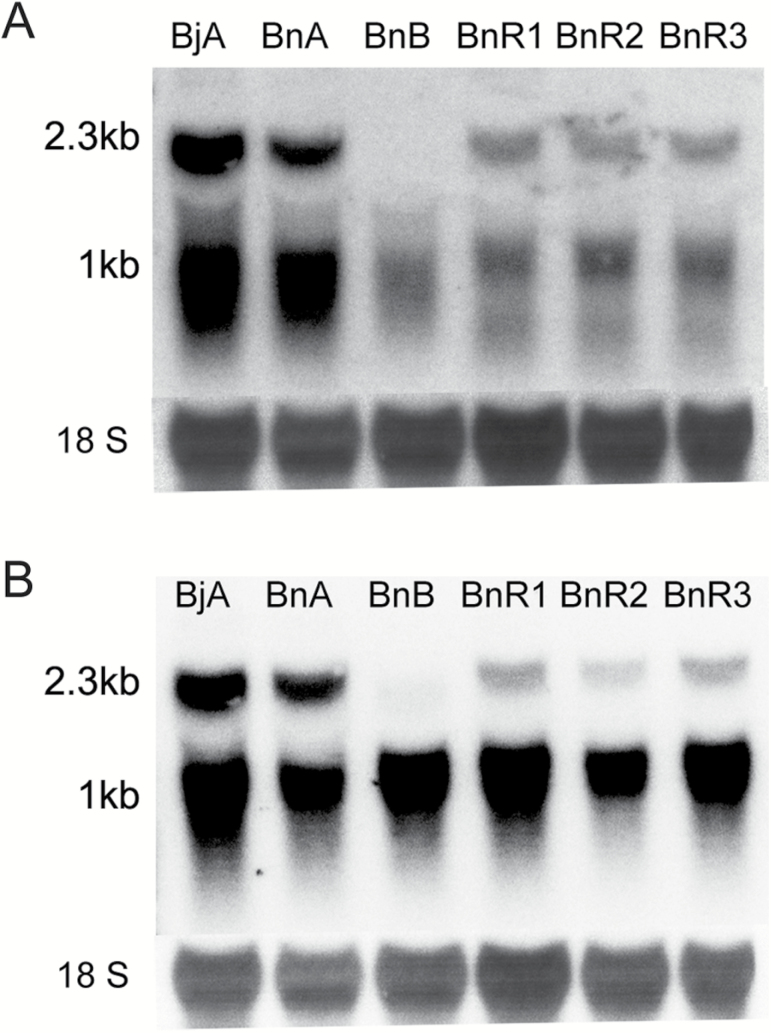

orf288 and atp6 expression patterns in the hau CMS lines. RNA gel-blotting analysis for (A) the orf288 and (B) the atp6 gene regions in the male-fertile, male-sterile, and nuclear-restorer floral buds: BjA, floral buds (<0.5 mm) from the hau CMS line (6-102A) in B. juncea; BjB, floral buds (<0.5 mm) from the hau CMS maintainer line (6-102B) in B. juncea; BnA, the male-sterile line in B. napus; and BnB, the maintainer line in B. napus. BnR1, BnR2 and BnR3 are different-sized floral buds (<0.5 mm; 0.5–2 mm; 2–4 mm) from the fertility-restorer line in B. napus.